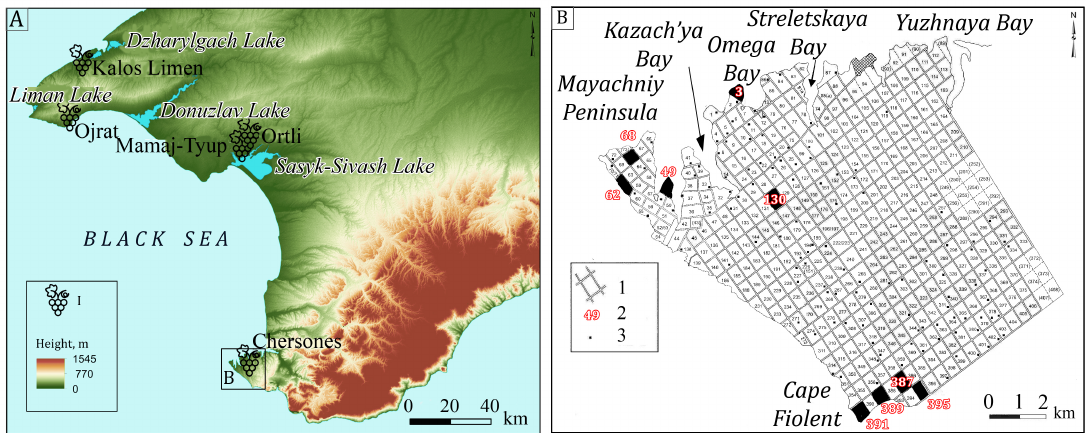
Figure 1. Objects of soil-genetic research in NW Crimea ( A ) and in plots of Chersonesos ( B ): 1—Division Lines; 2—Farm Number; 3—Farm Houses (Modified from